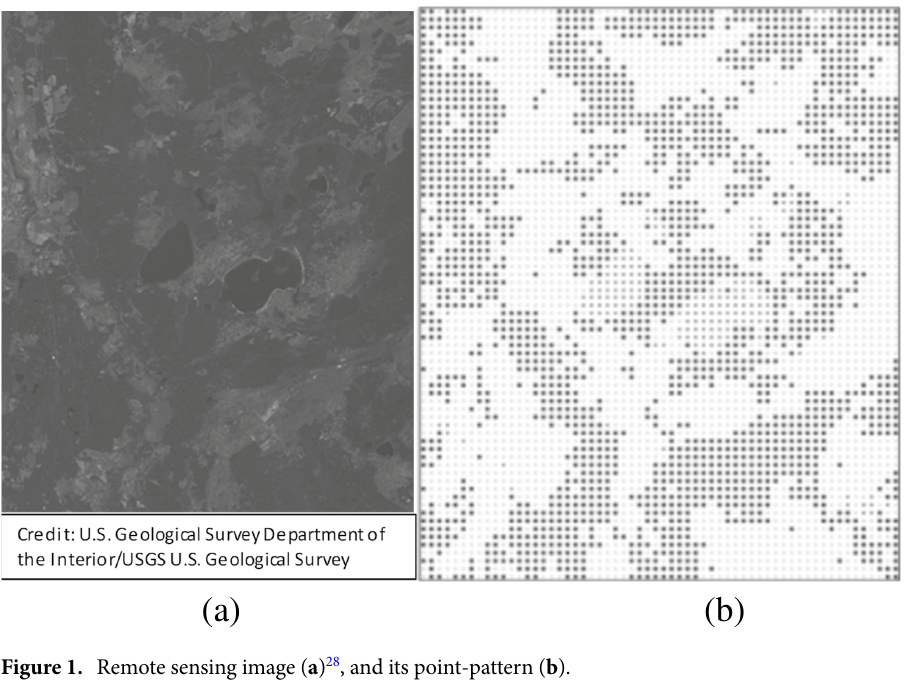
Figure 1. Remote sensing image ( a ) 28 , and its point-pattern ( b